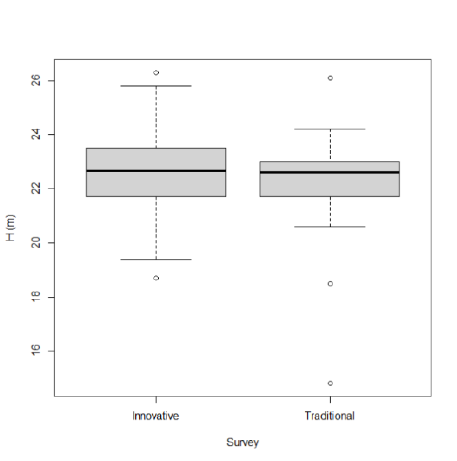
Figure 4.d Boxplots with resulting values for tree height (H) of plot 13-Beech